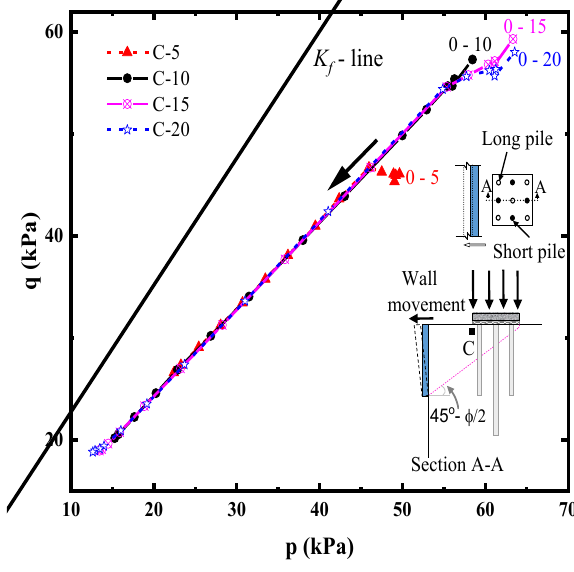
Figure 12: Influence of soil stiffness on the stress state during wall progression (e.g., 0-5 indicates initial stress state before wall movement for the case E = 5